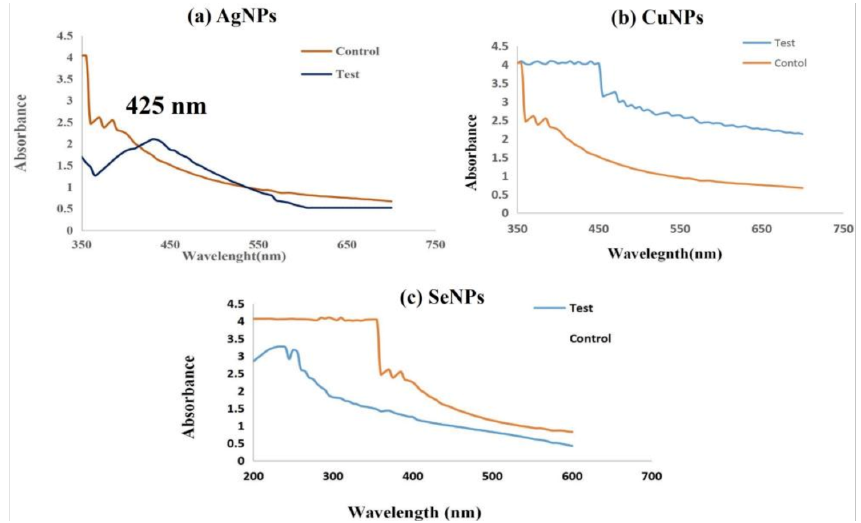
Figure 4. UV-Visible spectrum of synthesized silver nanoparticles (Test) showing maximum Plasmon surface peak at 425 nm ( a ). Maximum peak was not formed by copper nanoparticles ( b ) or Selenium nanoparticles ( c